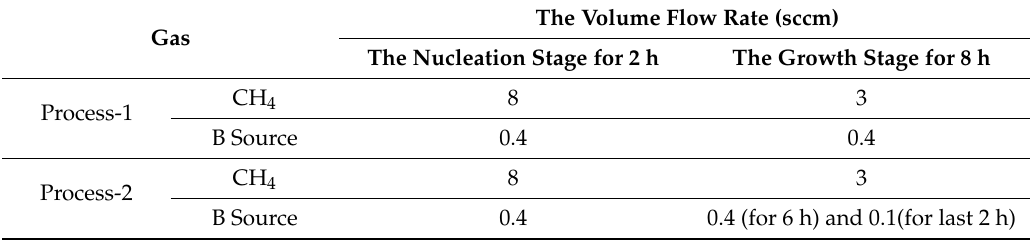
Table 3. Deposition parameters of the two